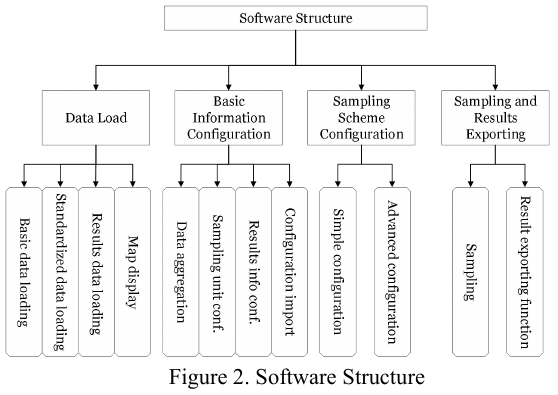
Figure 2. Software